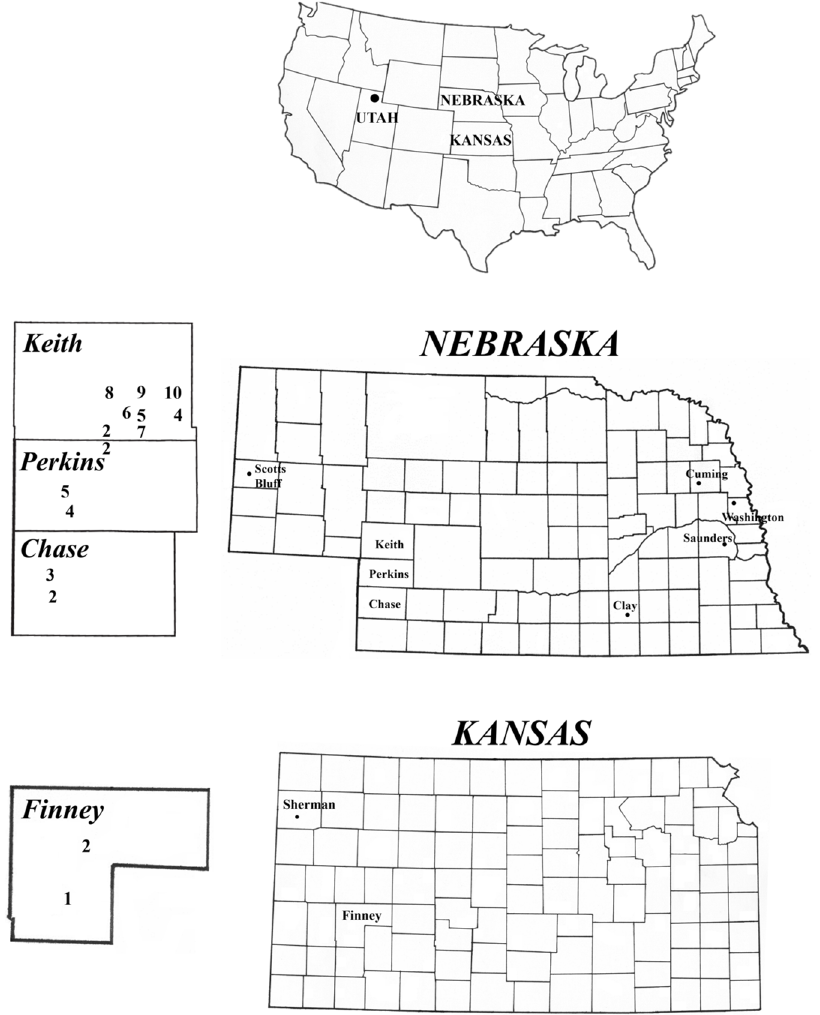
Fig 1. U.S. map showing states Utah, Nebraska(counties Keith, Perkins, Chase, Saunders, Clay, Cuming, and Washington), and Kansas (counties Sherman and Finney) where western corn rootworm beetles were collected for diagnostic concentration and susceptibility bioassays. Numbers in the enlargedcountiesKeith, Perkins, and Chase in Nebraska, and Finney in Kansas, correspond to population numbers listed from these countiesin Fig 2 and Tables 2–4 and show spatiallywhere collections were made. Dots within remaining countiesand Utah also show spatial locationsof